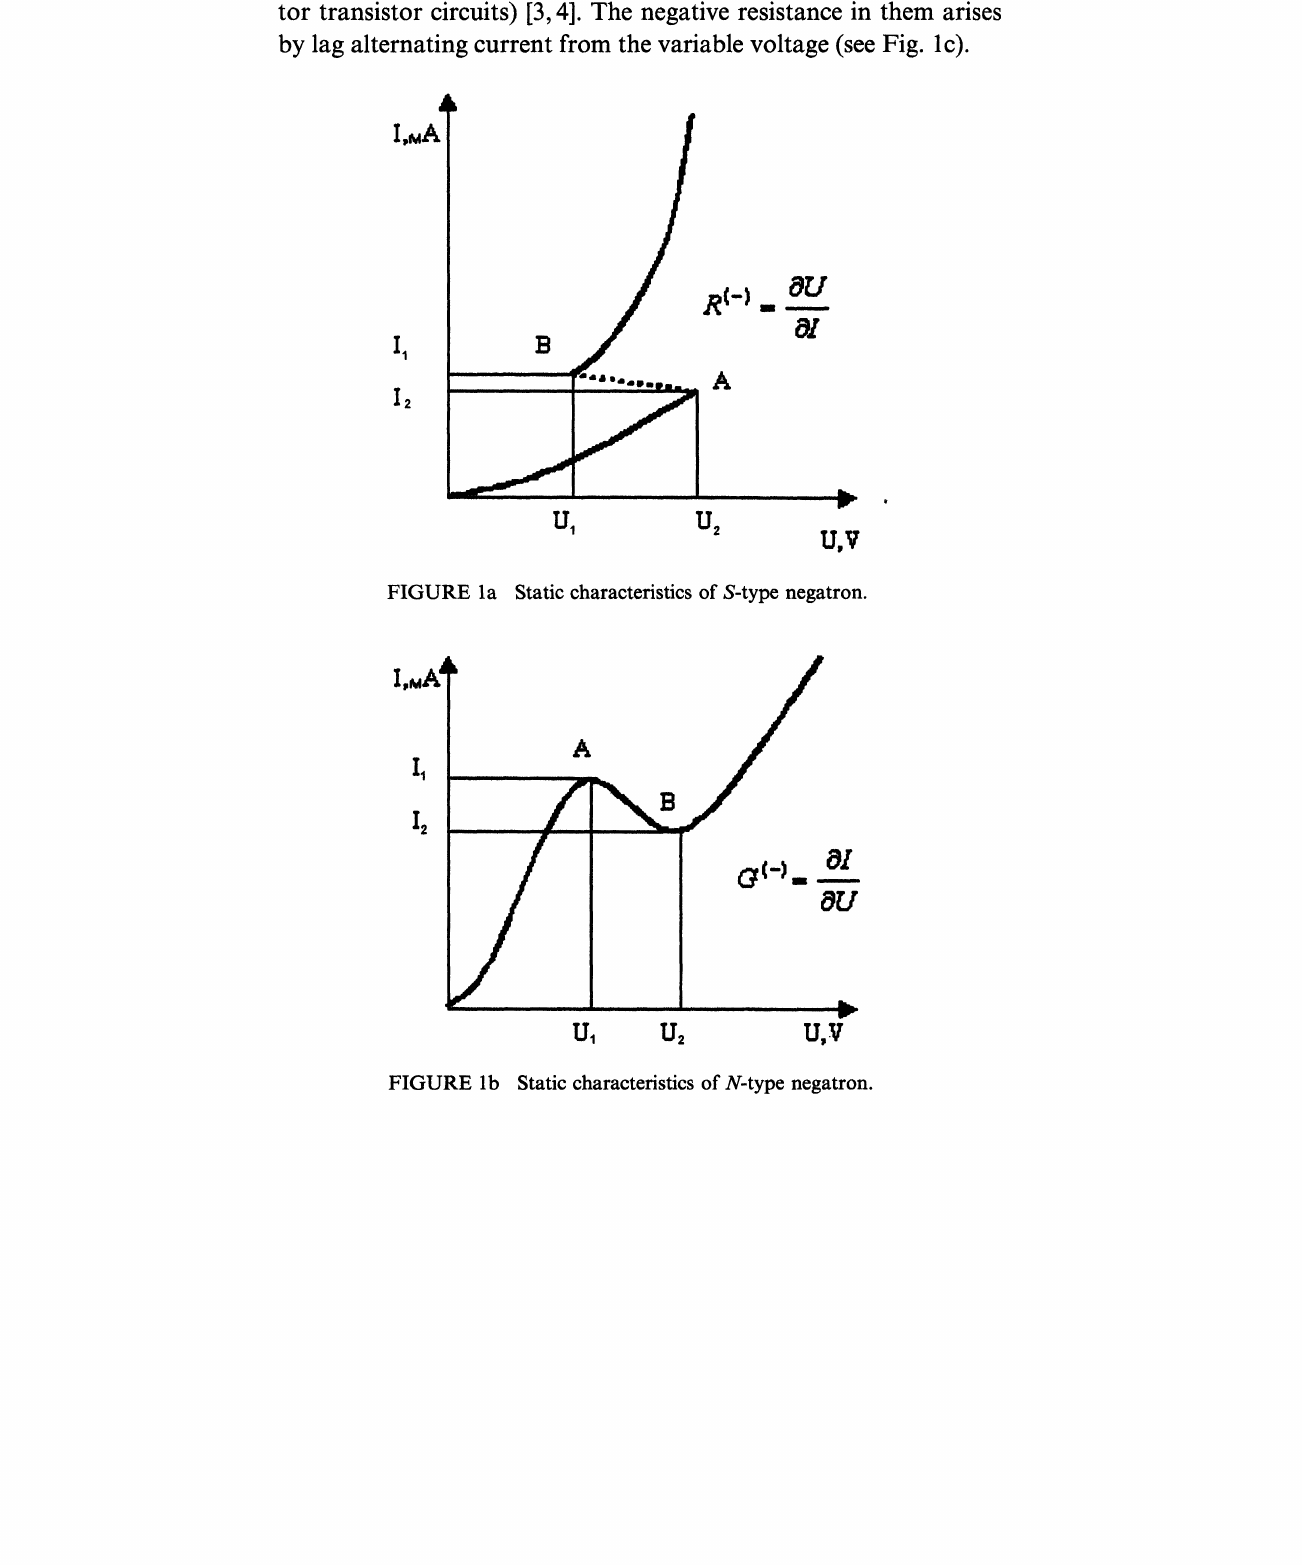
FIGURE b Static characteristics of N-type